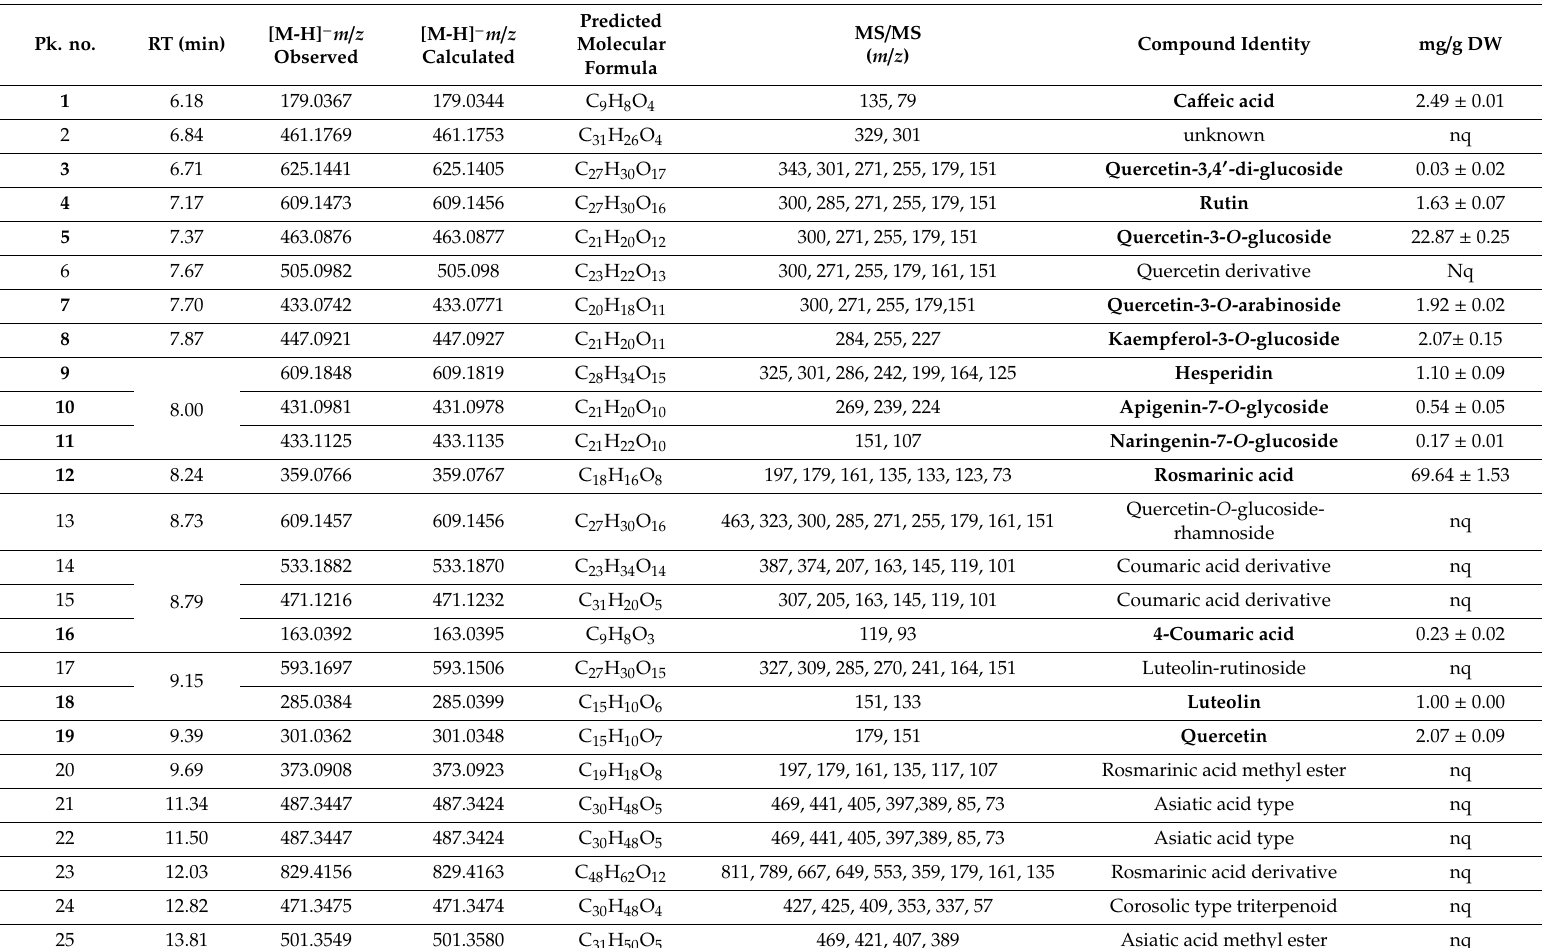
Table 3. Characterisation of phytochemicals present in ethyl acetate fraction of M. di ff usa by liquid chromatography-tandem mass spectrometry. Quantities of the detected compounds were determined using commercial standards (in bolds); nq = not quantified. Pk.